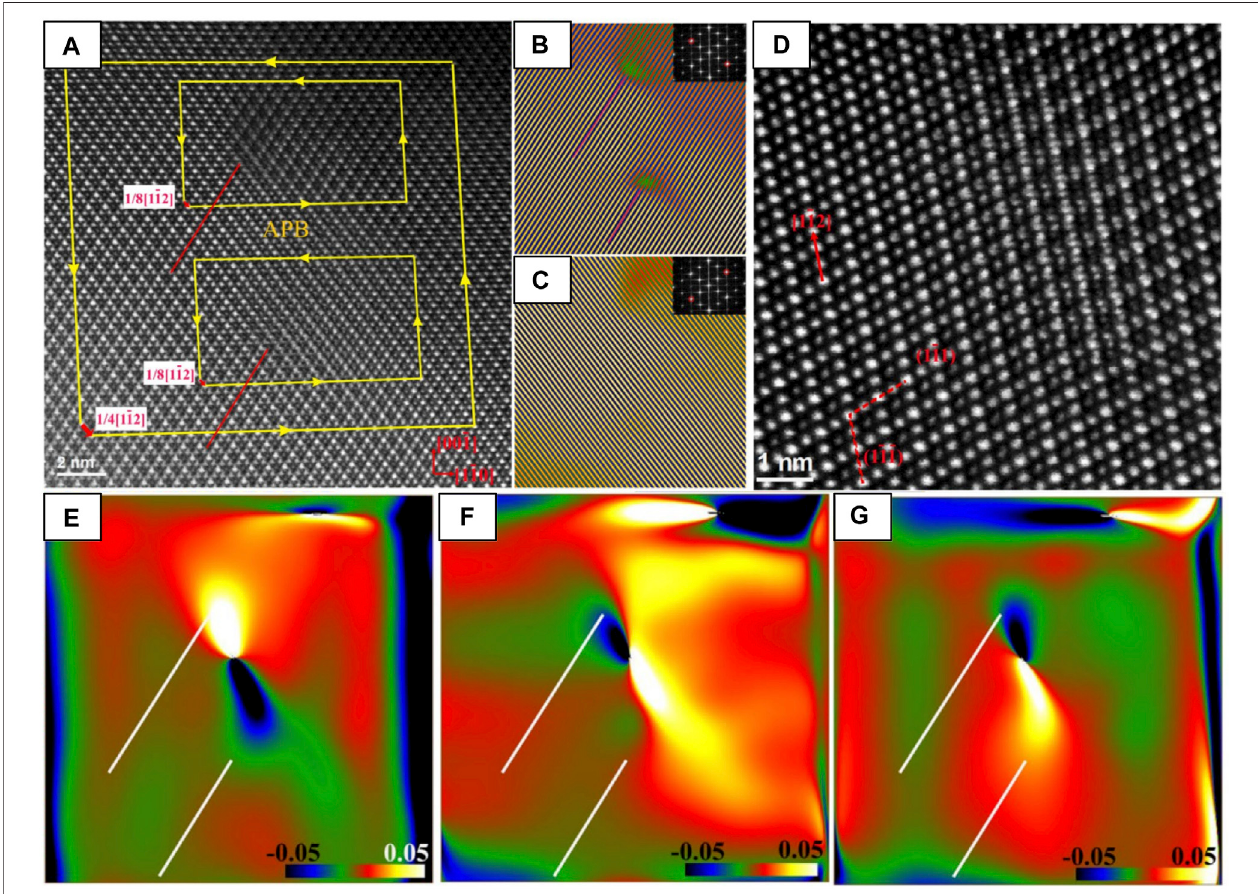
FIGURE7| AsuperdislocationwithBurgersvector1/4[112]. (A) ThedissociatedsuperdislocationwithtwopartialdislocationsandanAPB.ThreeBurgerscircuits areshownasyellowframes.TheprojectedBurgersvectorsareshownbytheredarrows. (B) InverseFFTimageusing g (cid:2) ± (222);inset:FFTdiffractionwith g circled. (C) Inverse FFT image using g (cid:2) ± (222); inset: FFT diffraction with g circled. (D) An enlarged HAADF STEM image of a 1/8 [112] partial dislocation. (E – G) ε xx along [110], ε yy along [001], and ε xy strain maps of (A) ; the location of the two extra atomic planes of the dislocation cores indicated by lines, reproduced from (Sha fi eizadeh et al., 2018).